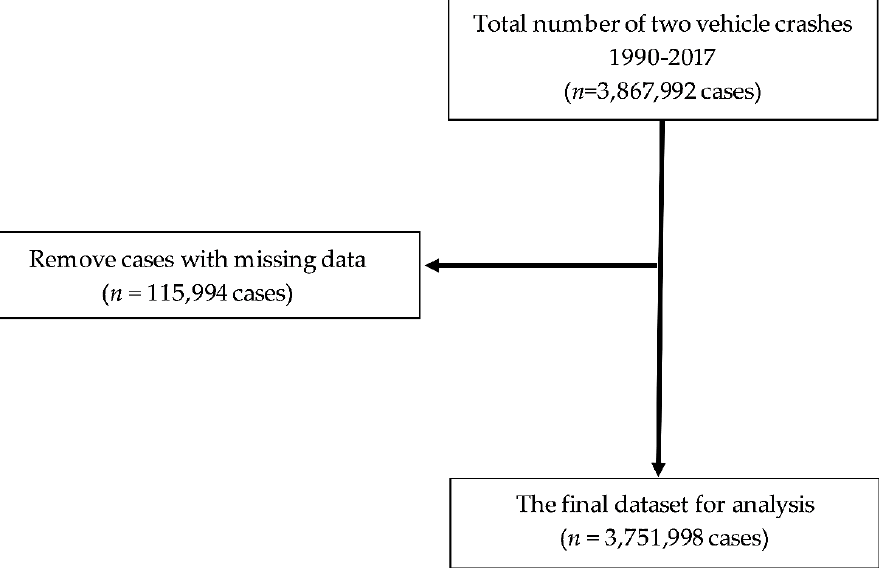
Figure 1. Flowchart of data sampling ( n = number of cases).